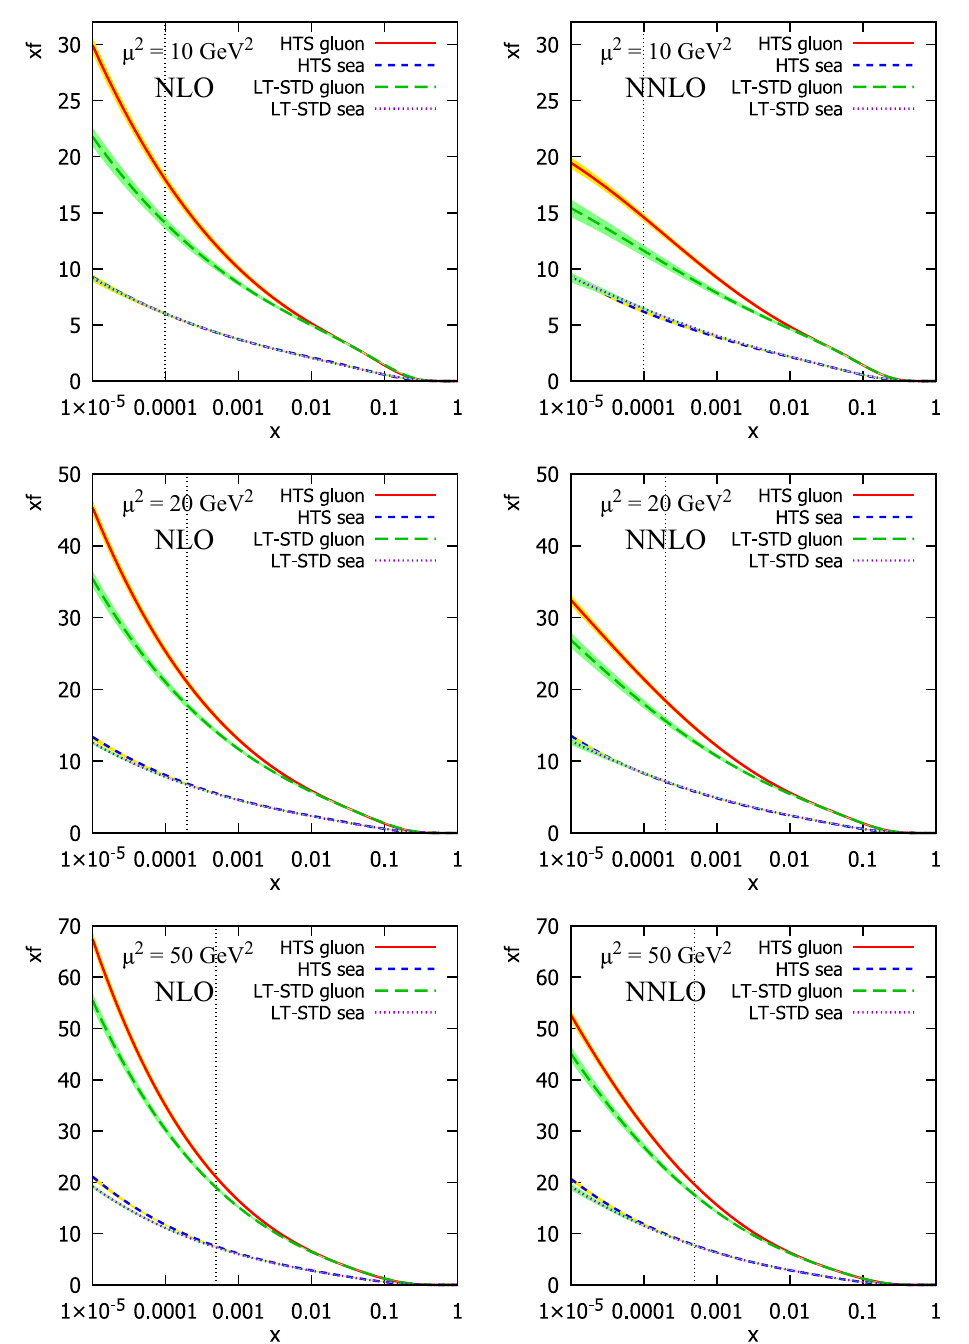
Fig. 8 Comparison of the HTS and LT-STD PDFs at μ 2 = 10GeV 2 (top), μ 2 = 20GeV 2 (middle) and μ 2 = 50GeV 2 (bottom). The experimental uncertainties are